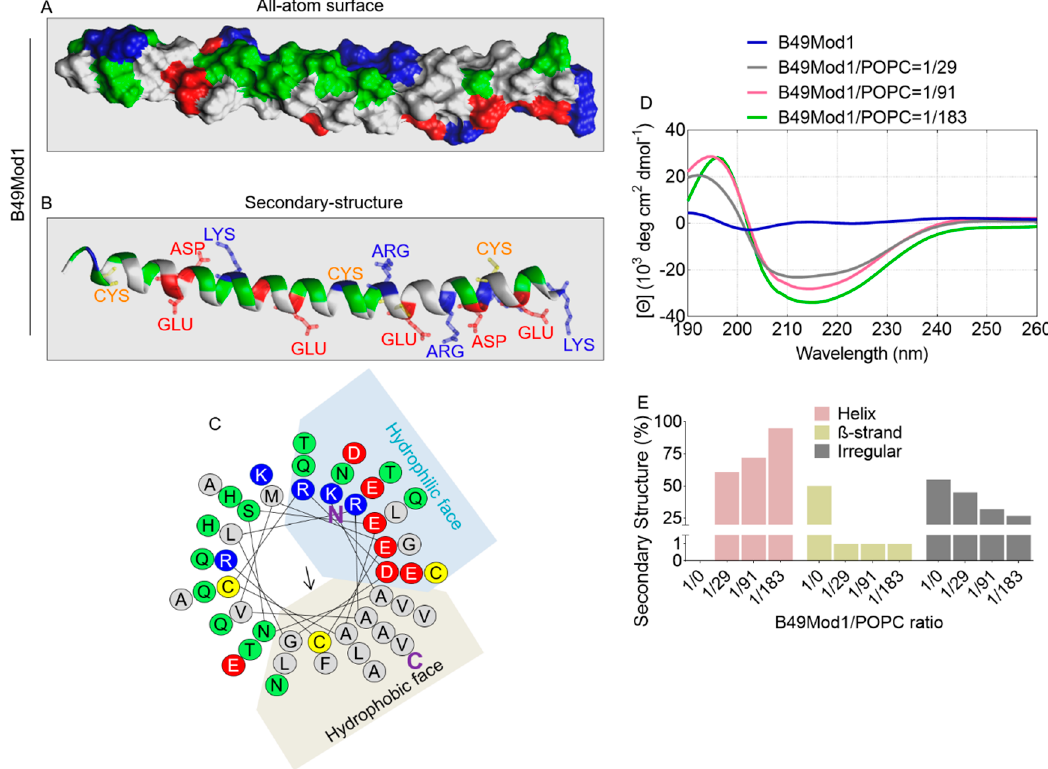
Figure 1. B49Mod1 structural information. ( A ) All-atom surface and ( B ) Secondary structure with thirteen residues’ side chains (GLU, ASP, ARG, LYS, and CYS). ( C ) Helical wheel projection of B49Mod1 core sequence, N : N-terminus and C : C-terminus. Color code for A-C: red: acidic residue, blue: basic residue, green: polar residue, white: non-polar residue and yellow: CYS residue. ( D ) Circular dichroism (CD) spectrum of B49Mod1 in water or in different concentrations of POPC lipid solution. ( E ) Predicted secondary structures based on the CD analysis.